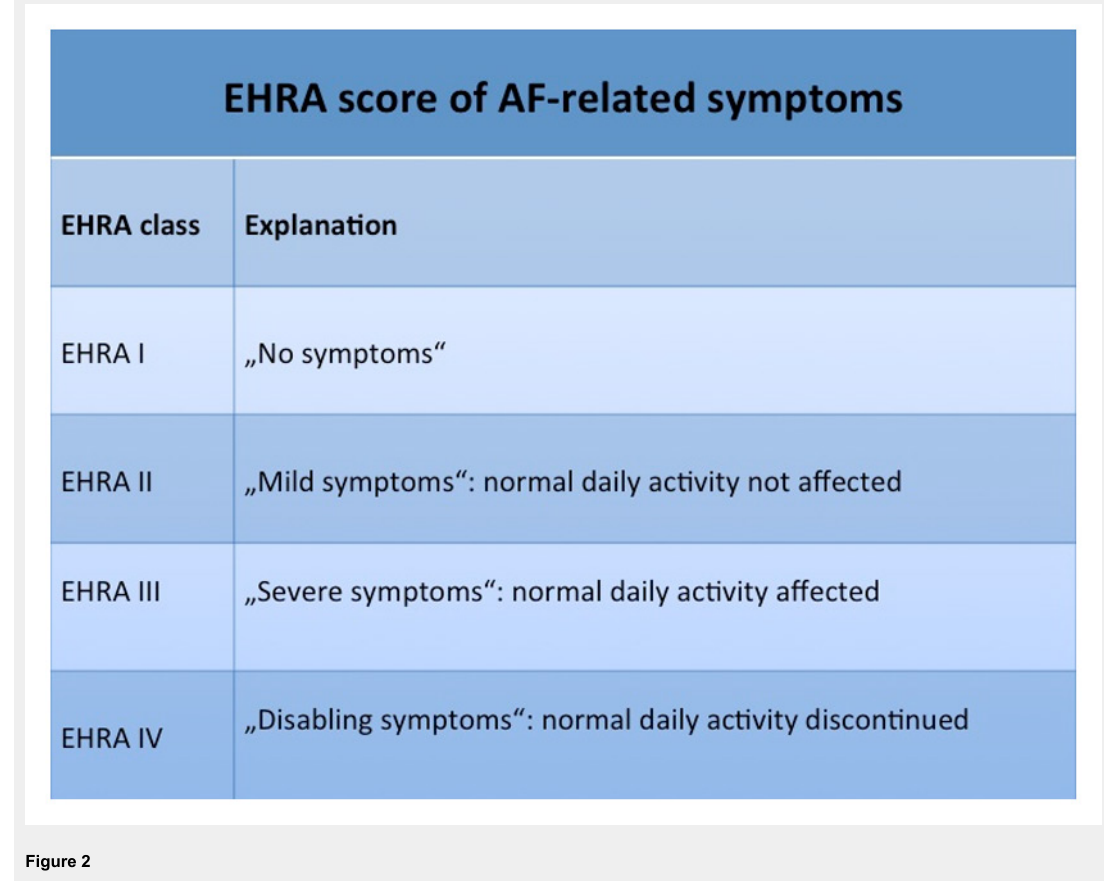
Figure 2 European Heart Rhythm Association (EHRA) classification of symptoms related to atrial